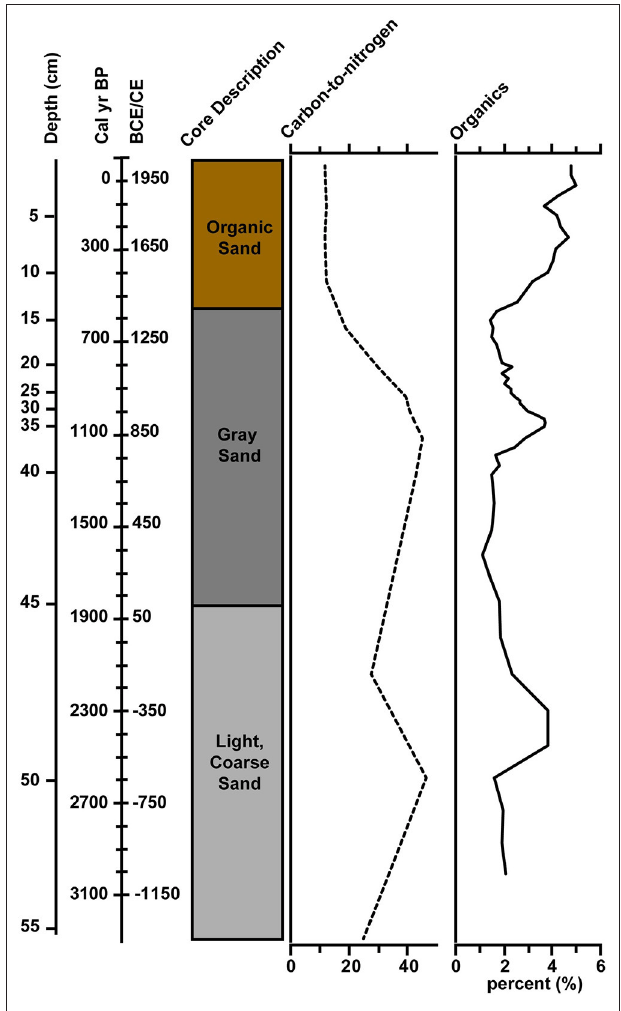
FIGURE 4 | Lithology and geochemistry (C:N ratios and percent organic